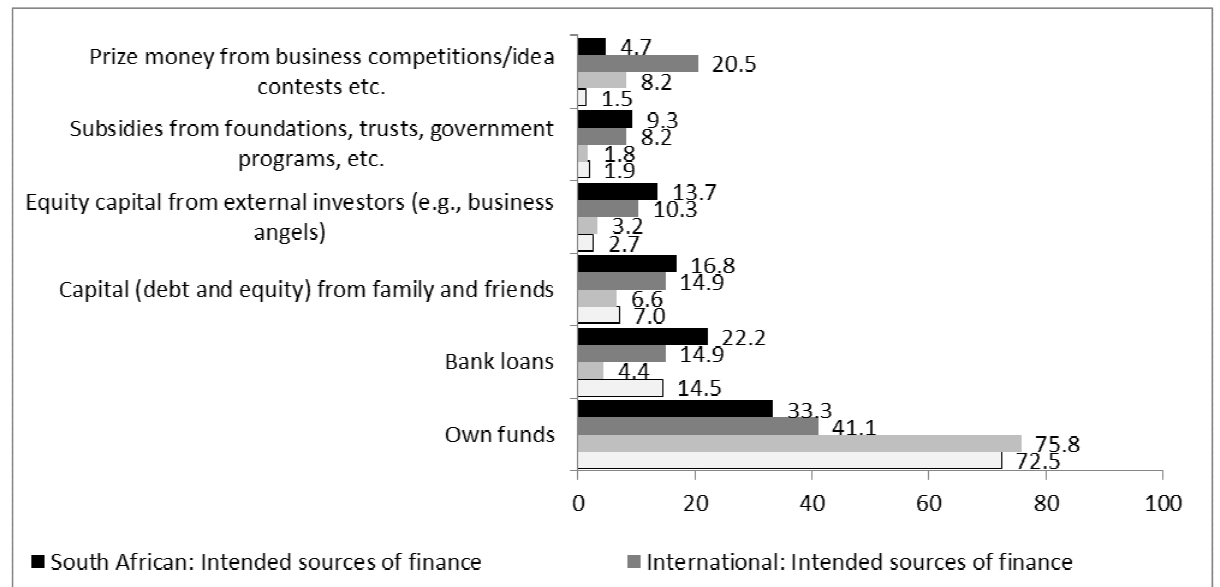
Figure 4 Comparison between intended and utilised sources of finance (in percentages) (Active founders: South Africa N = 17; international N = 2